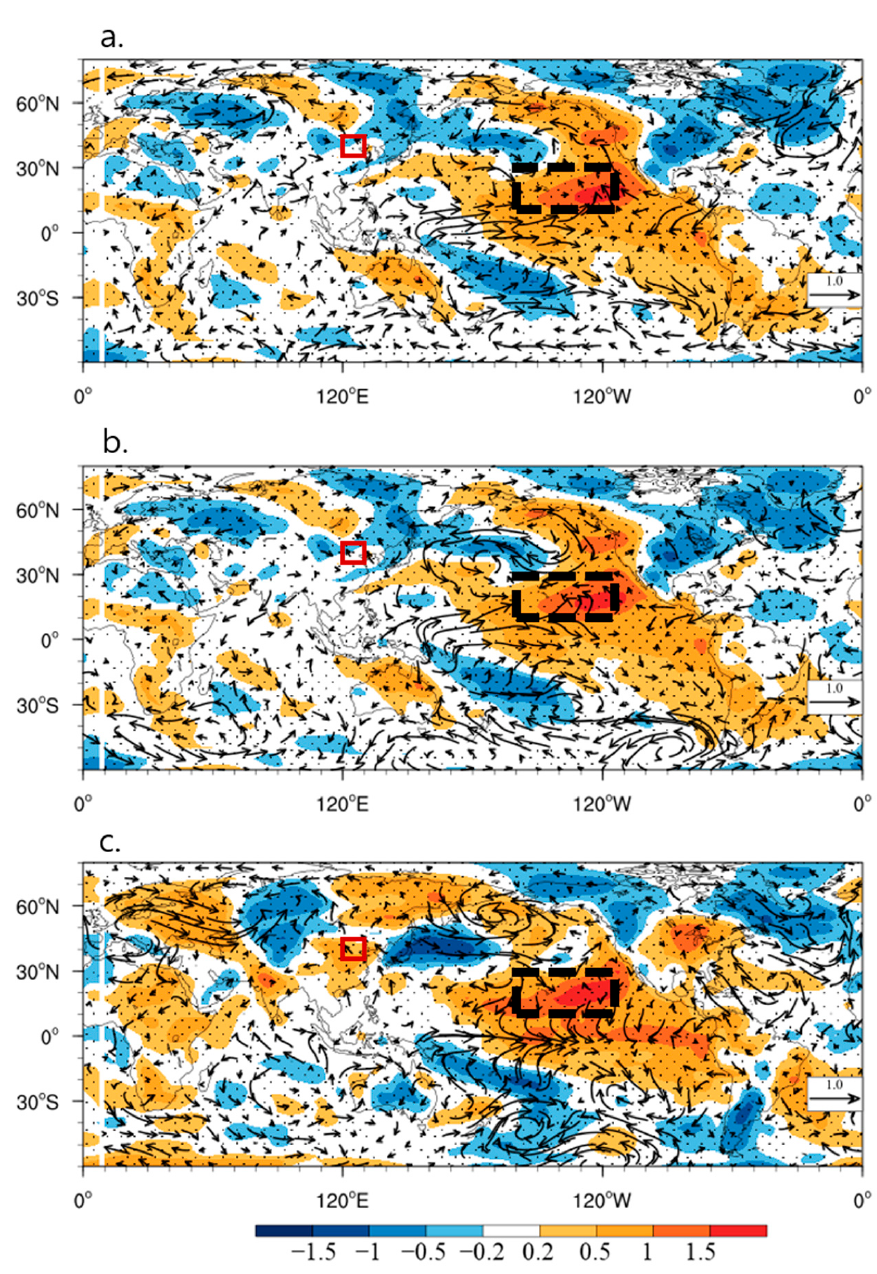
Figure 7. Regressed global t2m anomalies (shading; K) and surface wind anomalies (vector; m s − 1 ) in ( a ) July, ( b ) September, and ( c ) December onto Northeast Pacific SST anomalies in July from the observation. Stippling indicates significant regressed SST anomalies at the 95% level from Student’s t -test. Black vectors are significant regressed surface wind anomalies at the 90% level from Student’s t -test. The black dotted (red solid) box denotes the Northeast Pacific (North China).